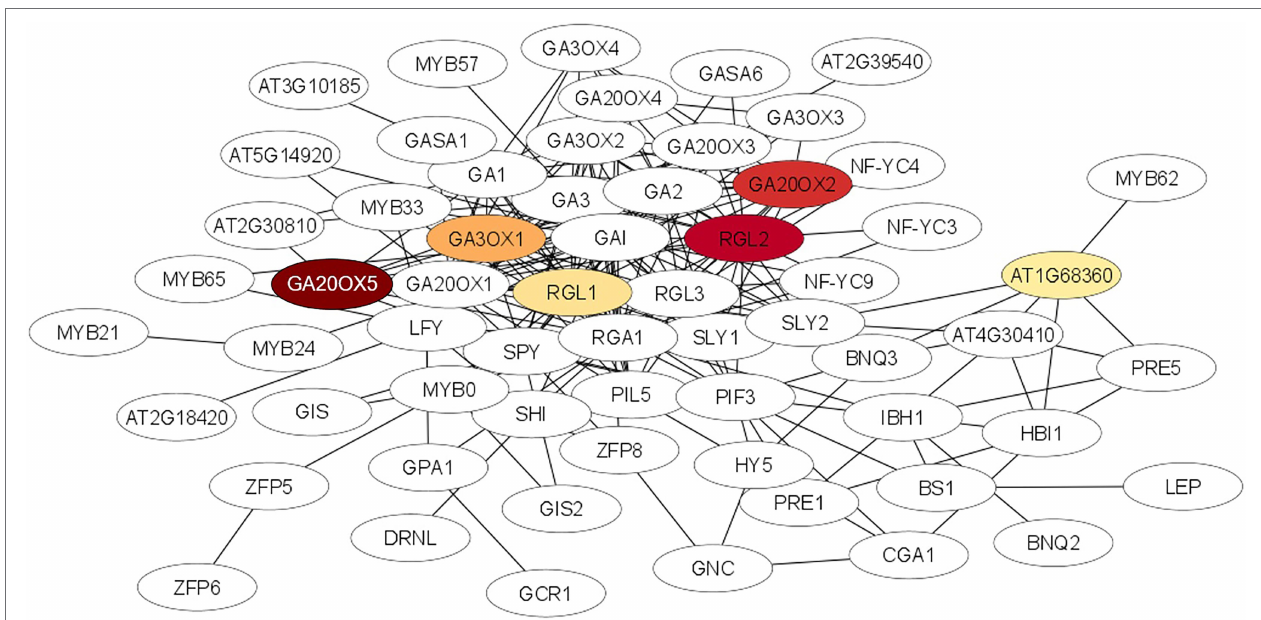
FIGURE 6 | Protein–protein interaction network for the gibberellic acid mediated signalling pathway which was significantly enriched (FDR < 0.001) after STRING analysis using the STRING database (http://string-db.org/). Nodes represent proteins, lines represent interactions between proteins. The intensity of the red color of the node represents the degree of upregulation of the gene in ARD tolerant wild species Mr5 compared to the susceptible rootstock ‘M9’. Nodes without a color were not differentially expressed or showed no differences in fold change values between ‘M9’ and Mr5. The network was generated using the Cytoscape